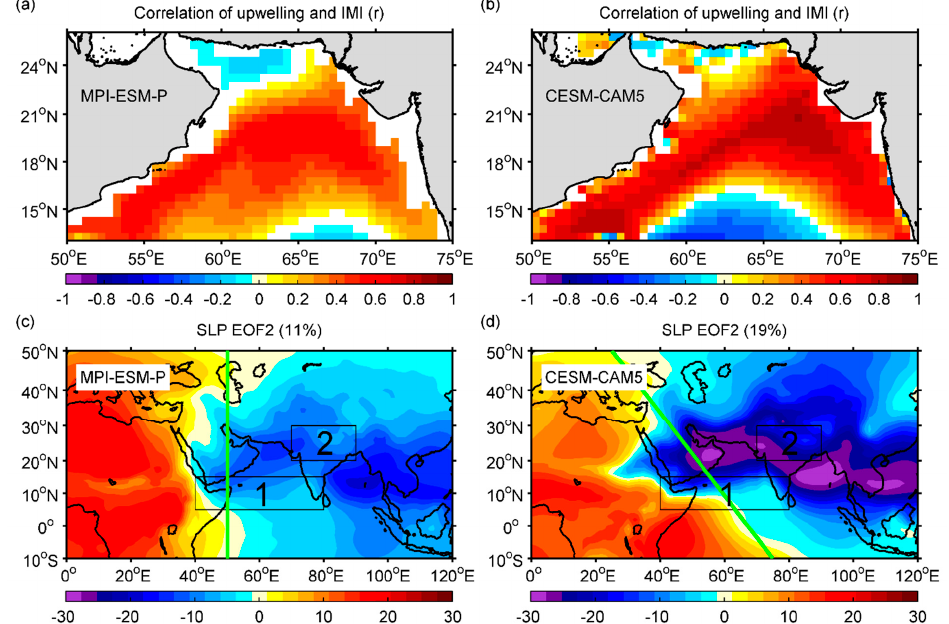
Figure 5. Correlation coefficient between the upwelling velocity and the IMI modeled by ( a ) MPI-ESM-P and ( b ) CESM-CAM5. The IMI is calculated by subtracting the U850 wind averaged in box2 from that in box1 (boxes shown in c, d). All the correlation coefficients are calculated from the detrended time series and are significant at the 95% significance level. The second EOF mode of JJA SLP modeled by ( c ) MPI-ESM-P and ( d ) CESM-CAM5 with their explained variance in brackets. The green lines demonstrate approximately the simplified boundaries that divide the positive and negative EOF phases.